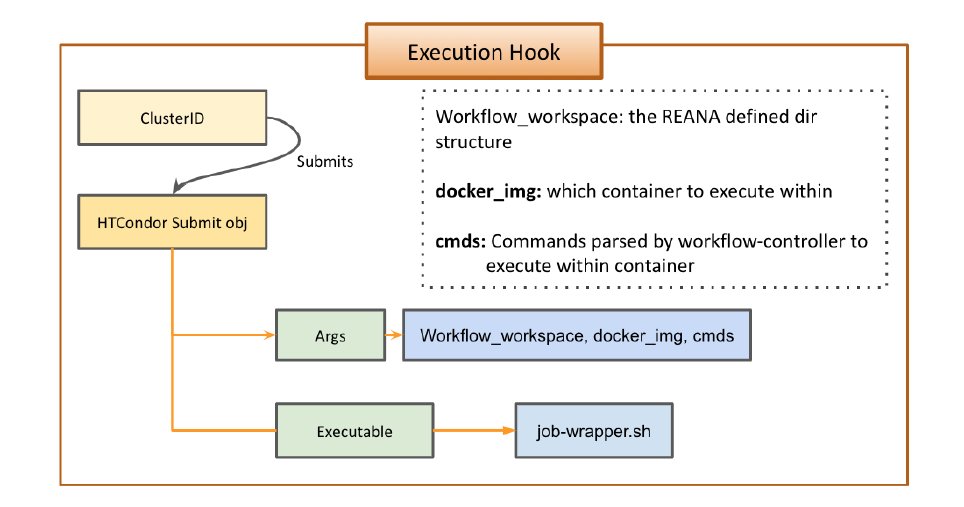
Figure 4. Job submit object creation and definition of arguments: workflow space absolute path, docker images and the commands to be executed